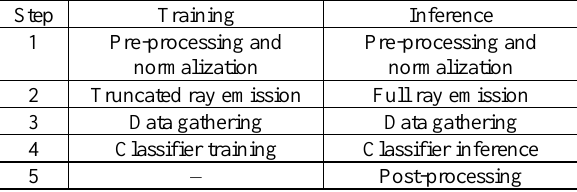
Table 1. Algorithm workflow for training and